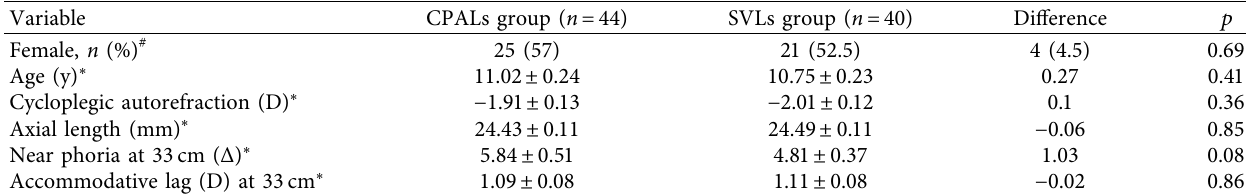
Table 1: Baseline characteristics (right eye only) of the participants by the study group.